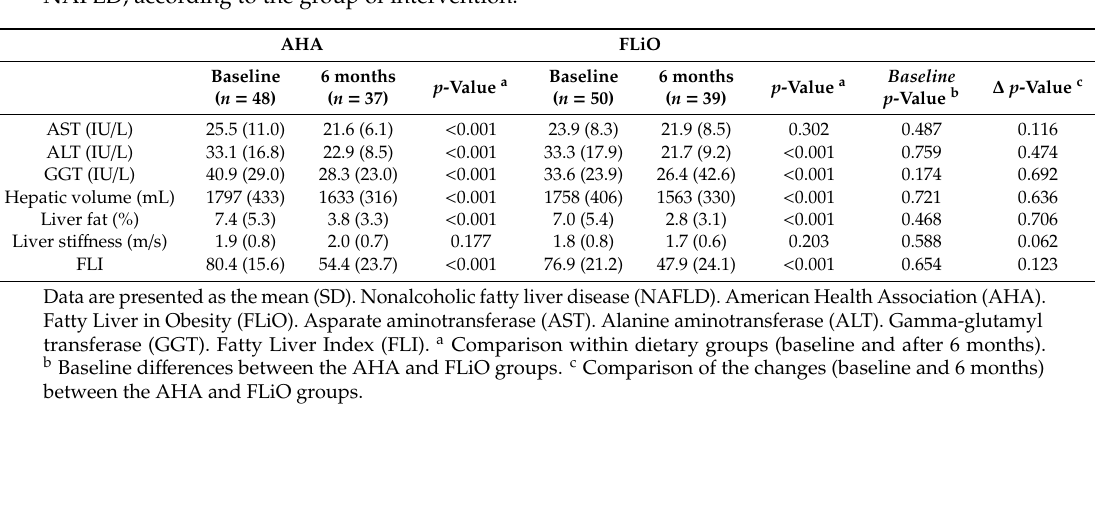
Table 2. Liver parameters at baseline and after 6 months of dietary intervention in subjects with NAFLD, according to the group of